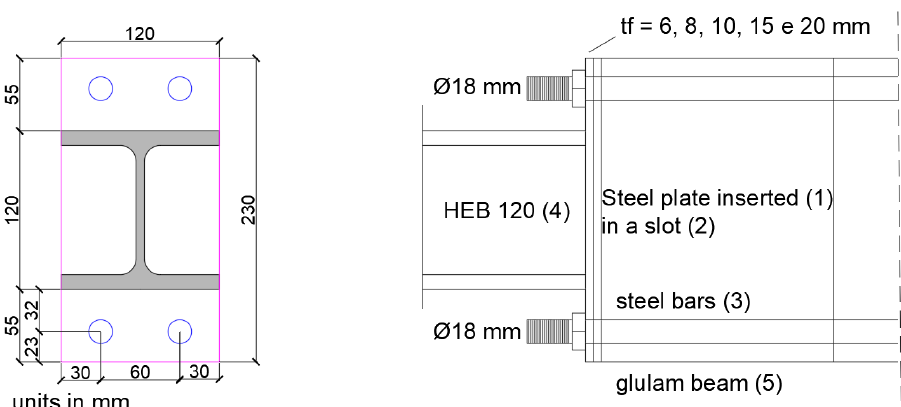
Figure 18. Joint parts configuration tested (adapted from Ref. [53]).